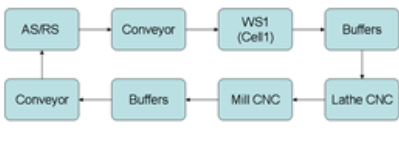
Figure 2. Part flow in the